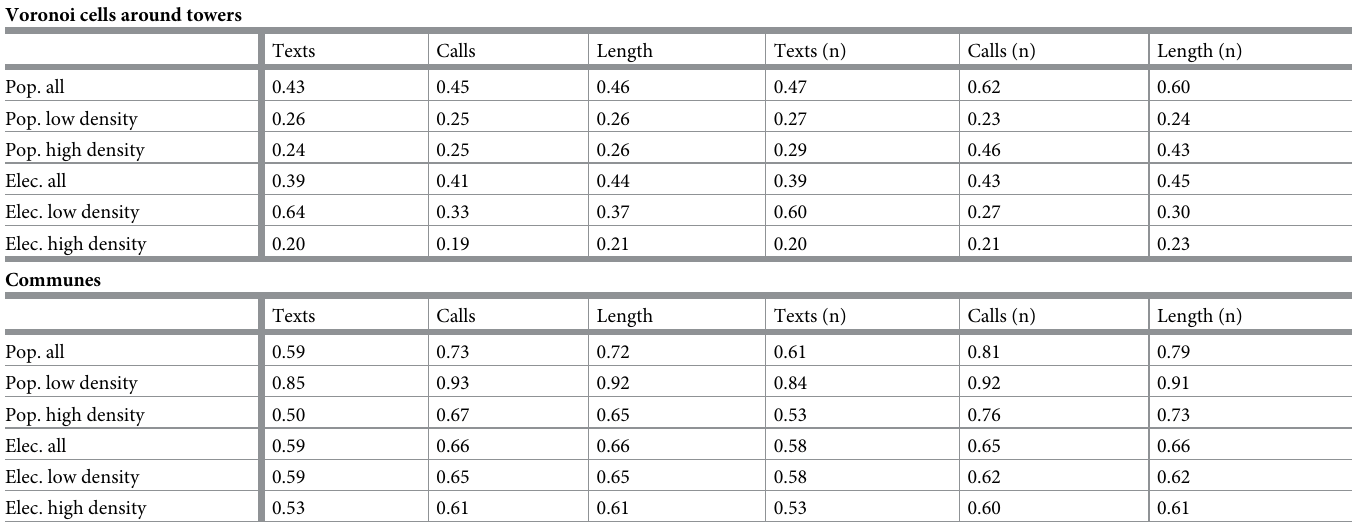
Table 1. Population density (Pop.) and nighttime lights (Elec.) correlations ( r 2 ) with number of texts, calls and total call length daily average values (per km 2 ) at tower and commune levels. (n) means that only the activity between 7 p.m. and 7 a.m. was included. For each case, three results are given: all areas included, only low den- sity areas included and only high density areas included. All p-values are < e − 15 . Voronoi cells around